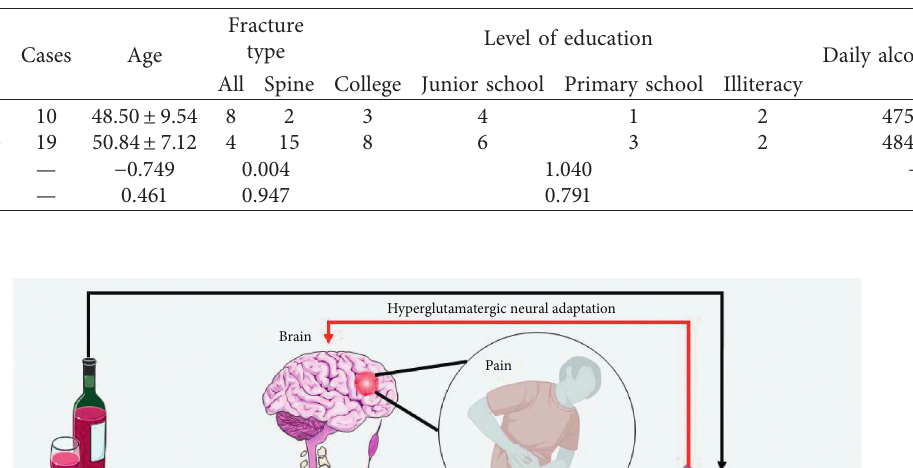
Table 1: General